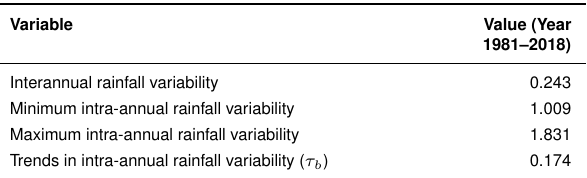
Table 1. Analysis of annual rainfall variability for 1981 to 2018.